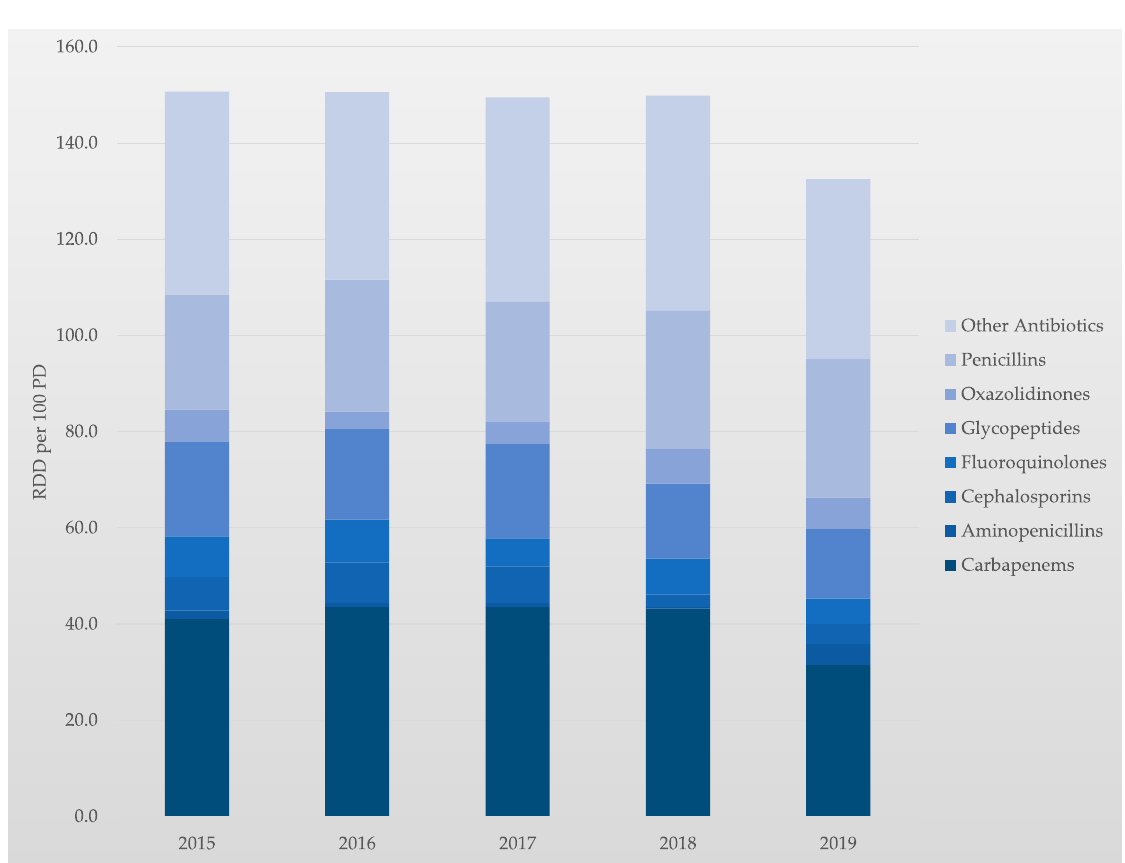
Figure 2. Application density of antibiotics in recommended daily doses (RDD) per 100 patient days (PD).